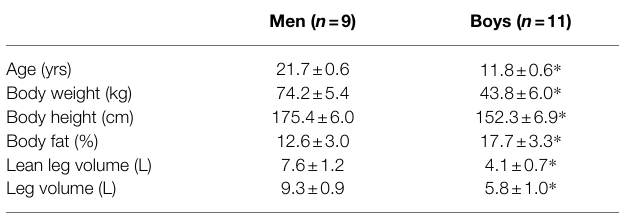
TABLE 1 | Anthropometric